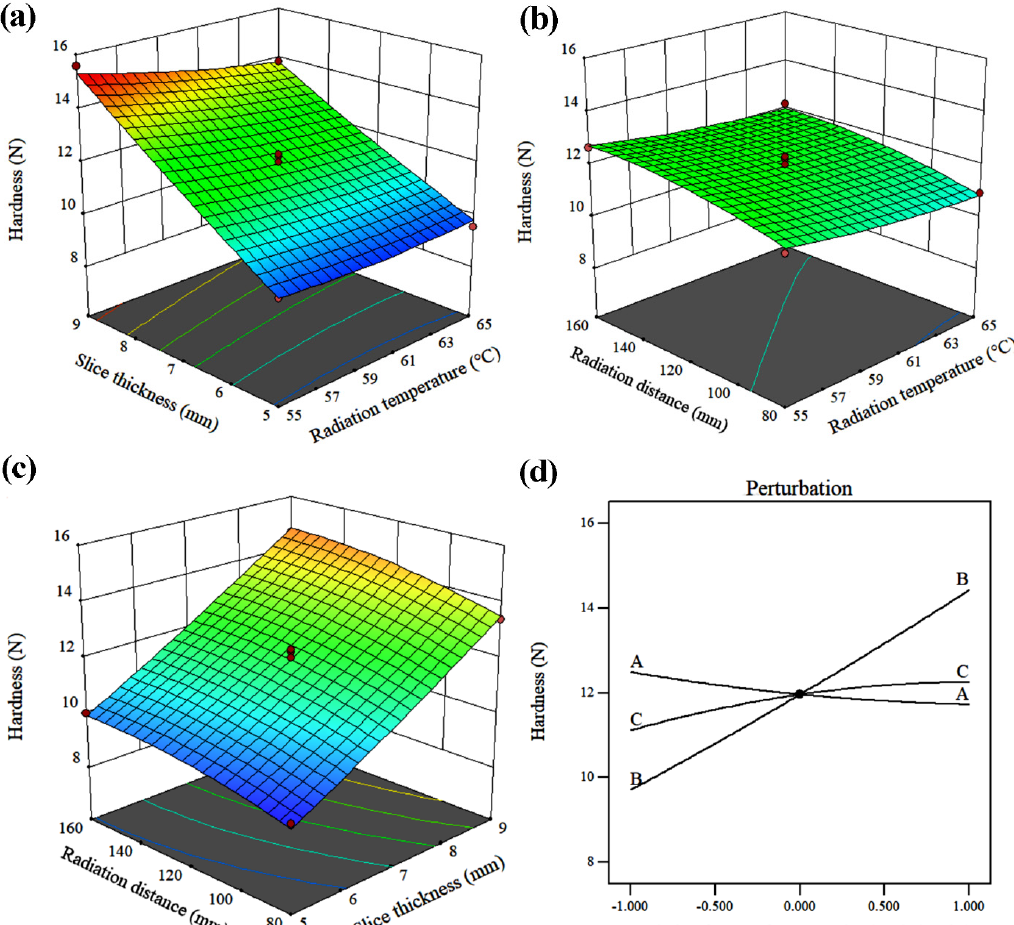
Figure 7. Response surface ( a – c ) and perturbation plot ( d ) for the effects of variables on the vitamin C content of cantaloupe slices.